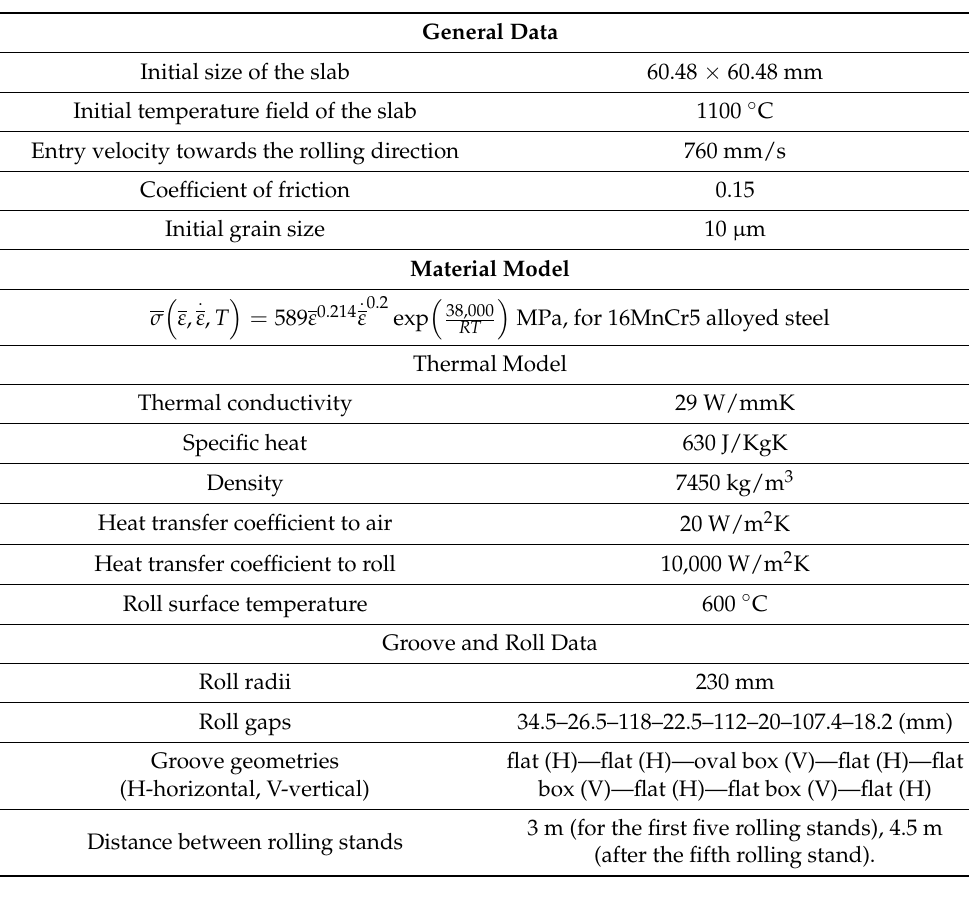
Table 7. Parameters used in the rolling simulation.